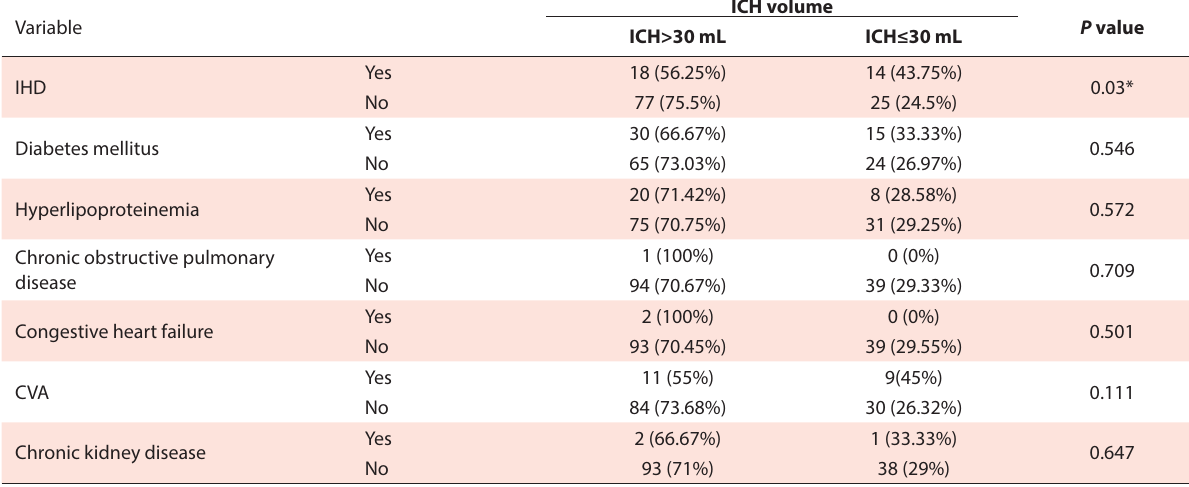
Table 2. Relationship between ICH volume and underlying comorbidities